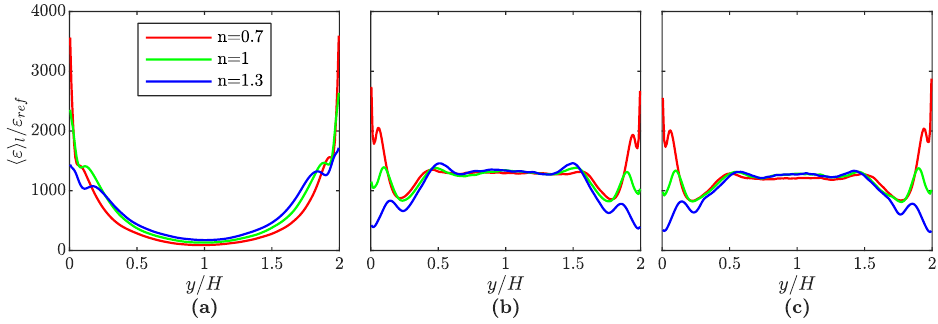
Figure 14. Average dissipation rate of the liquid phase (cid:104) ε (cid:105) l , normalized by ε ref , as a function of the wall-normal coordinate for the single-phase ( a ) and the two-phase setups with Eo = 0.3125 ( b ) and Eo = 3.75 ( c